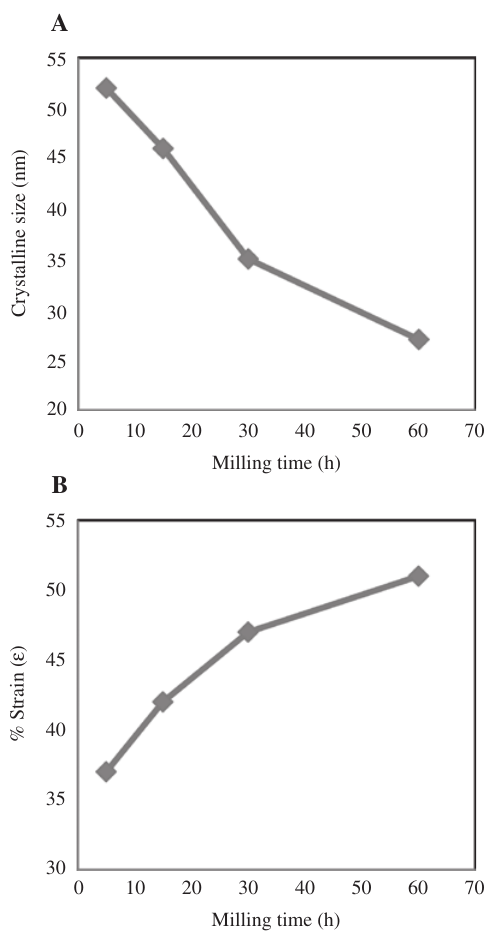
Figure 3: The increase in coercivity is attributed to the decrease in crystallite size. Variation of (A) average crystallite size and (B) lattice strain with milling time for Cu